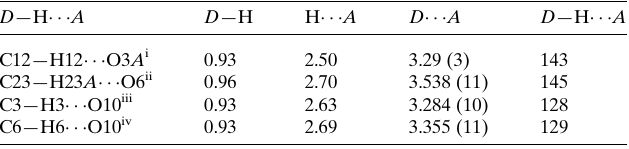
Table 2 Hydrogen-bond geometry (A˚ , (cid:3) ).